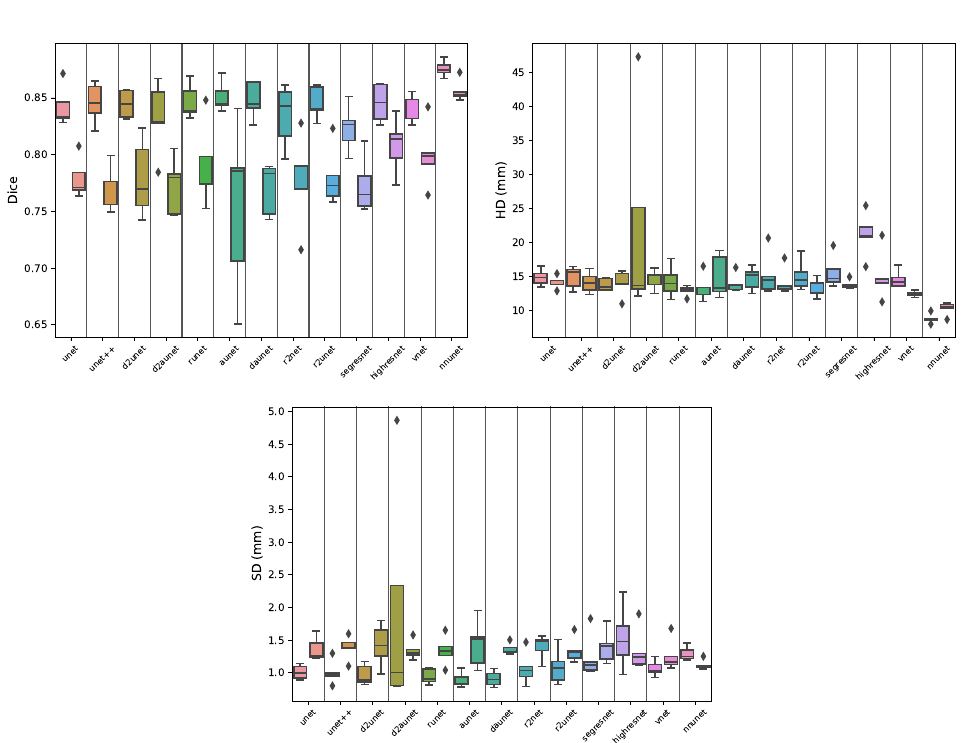
Figure 6. Boxplots showing the distribution of Dice, Hausdorff distance (HD) and Surface distance scores per model during cross-validation for the transition segmentation task. Each segment contains a pair of boxplots, where the left one corresponds to the results of the model on the full data, and the right one on the cropped